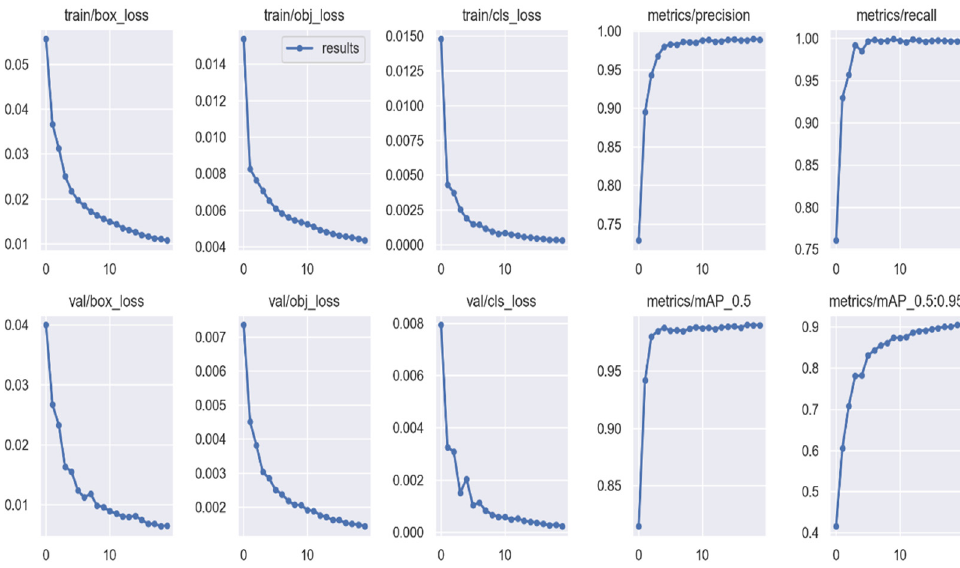
Figure 8. Variation diagram of model loss function during